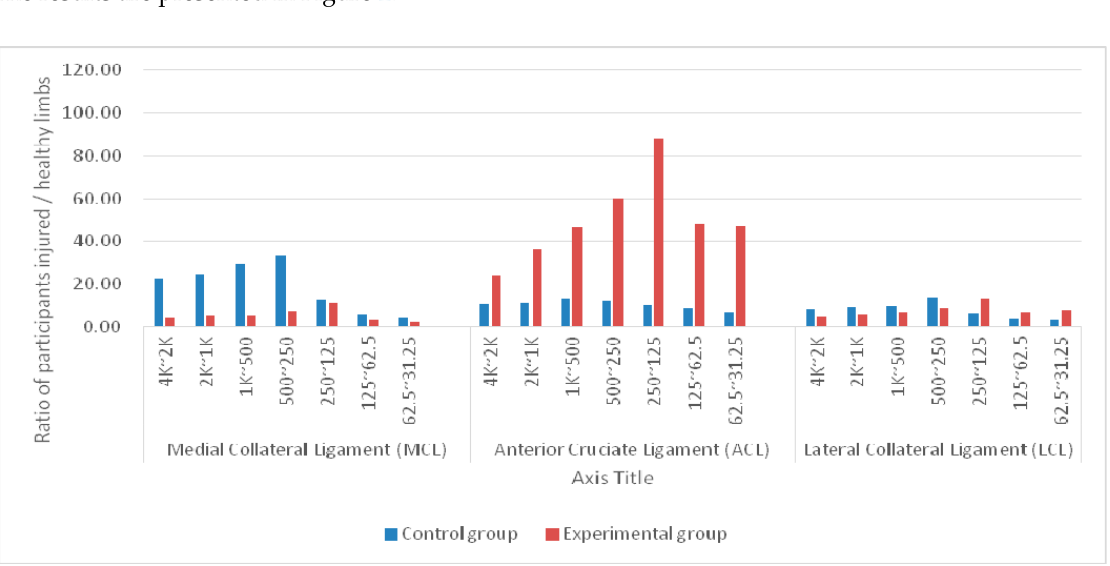
Figure 2. Average differences in signal bands at the medial collateral ligament (MCL), anterior cruciate ligament (ACL), and lateral collateral ligament (LCL) sensing points of injured and healthy limbs between control (n = 27) and experimental (n = 38) groups before surgery.